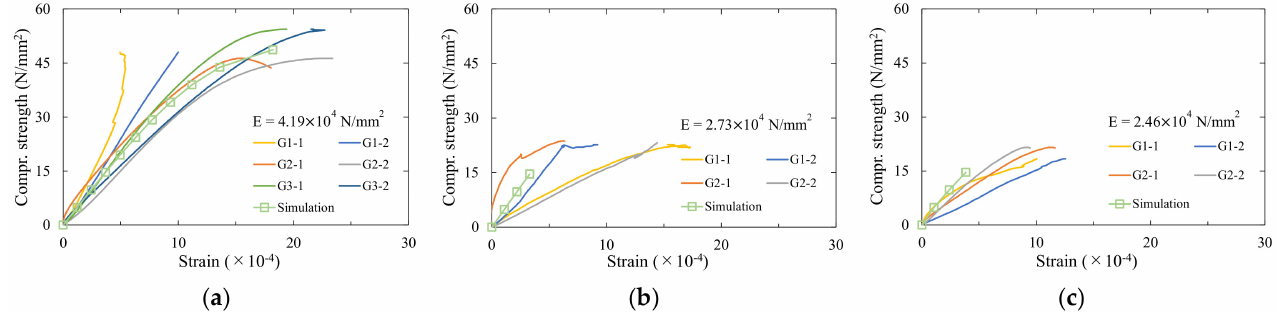
Figure 16. The density and compressive strength of 2008 CS concrete.